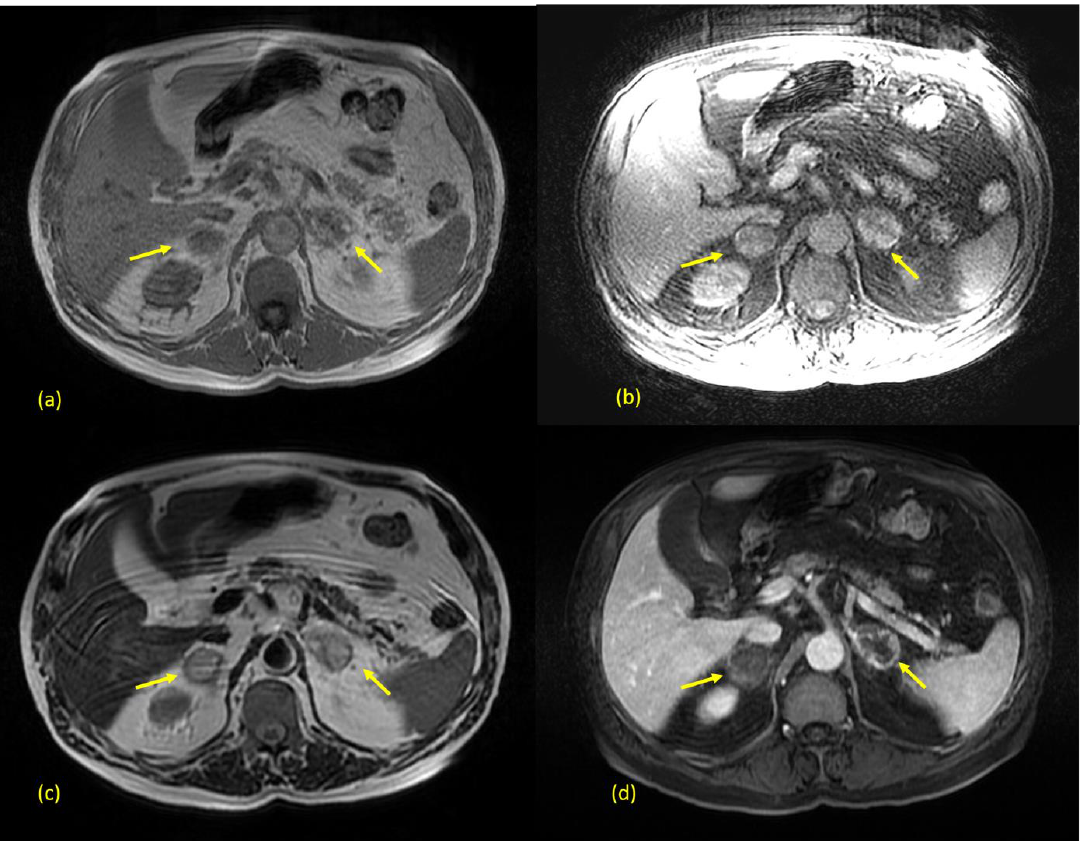
Figure 3. ( a ) MRI axial T1 weighted. ( b ) MRI axial T1 weighted with fat suppression. ( c ) MRI axial T2 weighted. ( d ) MRI axial T1 weighted with fat suppression after contrast. Arrows indicate the adrenal glands. Some motion artifacts are present. The MRI performed 13 days after onset confirms an enlargement of adrenal glands with hyperintense areoles in both T1- and T2-weighted sequences, suggestive of subacute stage hematoma. After intravenous contrast, peripheral linear enhancement is observed, and it is more evident in the left gland and referred to compressed residual glandular parenchyma.